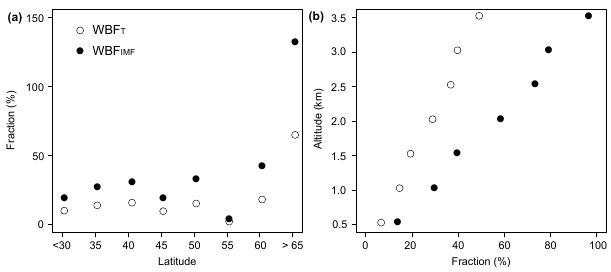
Figure 4. GESO-Chem-simulated fractional change to BC concentration, relative to riming-only, as a result of WBF, ([BC] WBF − [BC] riming ) /[BC] riming that varies with (a) altitude and (b) latitude, averaged for